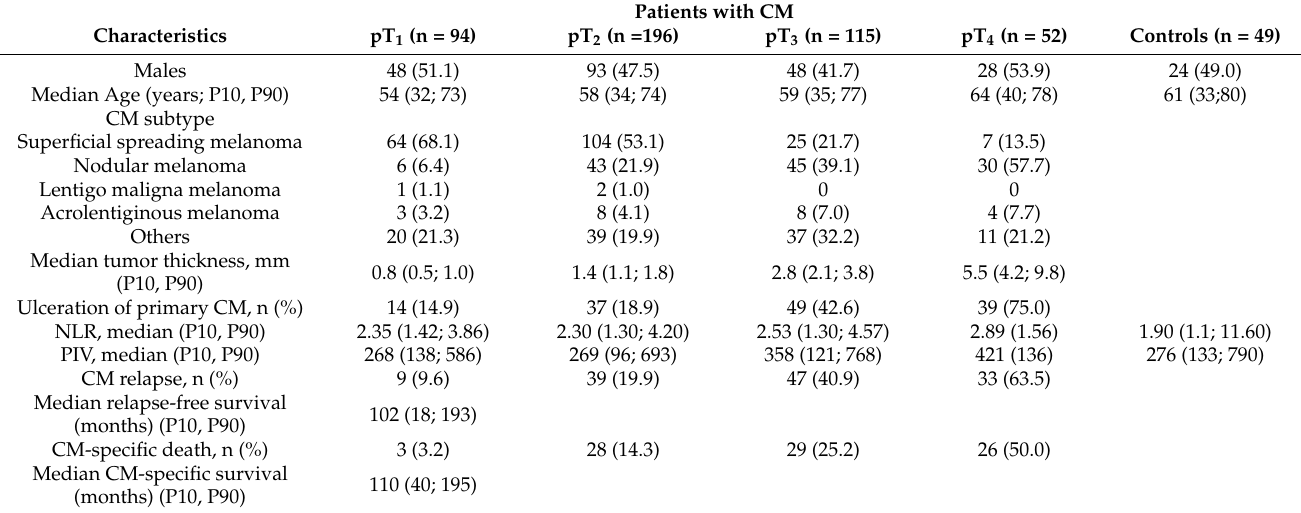
Table 1. Clinical characteristics of patients with cutaneous melanoma (CM, n = 457) in pT stages 1–4.